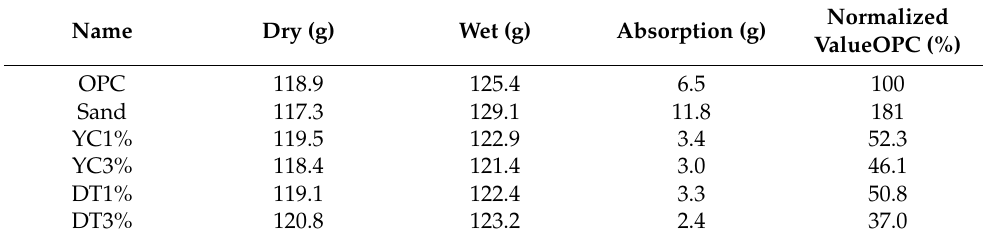
Figure 12. Measurement of Water absorption test (91 d). Table 7. Measurement of the Water absorption test (91 d).